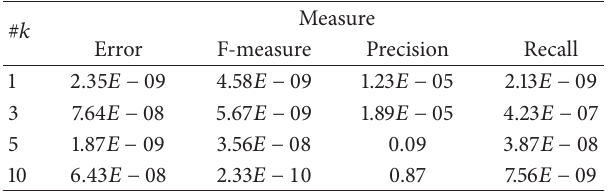
Figure6:Erroroftheconventional 𝑘 -NNclassifierandtheweighted 𝑘 -NN classifier on different 𝑘 . Table 3: The 𝑃 values of the 𝑡 -test on the weighted and conventional 𝑘 -NN classifiers.